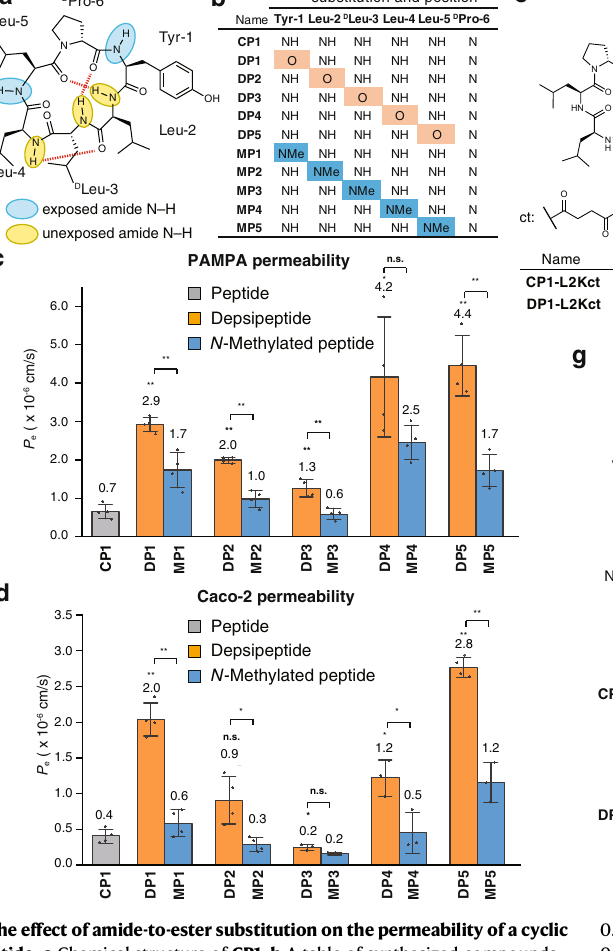
Fig. 2 | Theeffect ofamide-to-estersubstitutiononthepermeability ofacyclic hexapeptide. a Chemical structure of CP1 . b A table of synthesized compounds. The position of an amide-to-ester substitution and amide N -methylation is shown byOhighlightedinorangeandNMehighlightedinblue,respectively. c PAMPAand d Caco-2 assay of synthesized cyclic peptides. PAMPA was conducted with 2 μ M compoundsinPBScontaining5%DMSOand16hincubationat25°C.CyclosporinA (CSA) was included as a control for PAMPA (0.4 × 10 − 6 cm/s). Each bar represents themeanvalue,andtheerrorbarsthestandarddeviationfromexperimentscarried out in quadruplicate. Caco-2 assay was conducted with 1 μ M compounds in HBSS (pH 7.4) containing 10mM HEPES and 1% DMSO and 3h incubation at 37°C. Each bar represents the mean value, and the error bars the standard deviation from experiments carried out in triplicate ( DP3 , DP4 , MP4 , and MP5 ) or quadruplicate (otherthan DP3 , DP4 , MP4 ,and MP5 ).Thestatisticalsigni fi canceof DP1 – 5 against CP1 is shown above the bar of DP1 – 5 and the statistical signi fi cance of DP1 – 5 against MP1 – 5 is shown above the bars of DP1 – 5 and MP1 – 5 . P values were determined by a two-sided Welch ’ s t -test. ** p <0.01, * p <0.05. n.s. denotes not signi fi cant. p ( CP1 vs. DP1 )<0.0001, p ( DP1 vs. MP1 )=0.0092, p ( CP1 vs. DP2